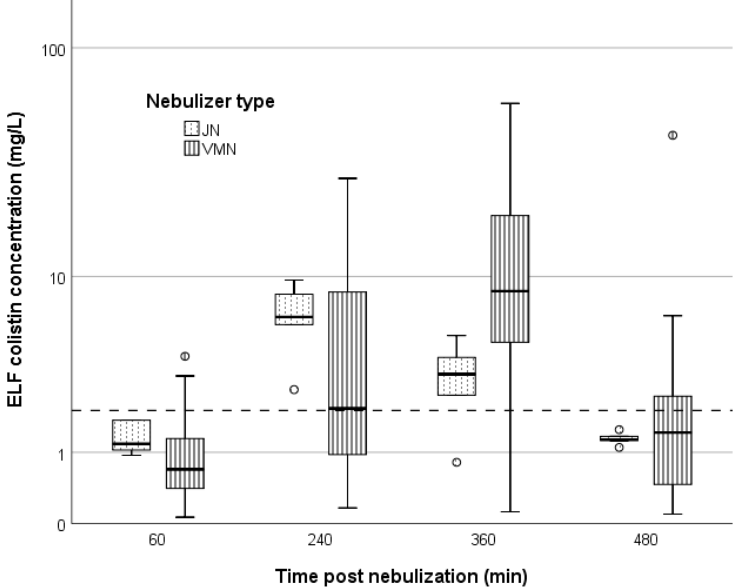
Figure 2. Colistin concentration in the ELF at 60, 240, 360 and 480 min after inhalation of 2 million international units of colistimethate sodium via jet nebulizers (dotted boxplots) or vibrating mesh nebulizers (vertical line boxplots). The dashed line represents the European Committee on Antimicrobial Susceptibility Testing (EUCAST) breakpoint for susceptible Enterobacterales and Acinetobacter spp. (2 mg/L). Circles represent outliers. ELF: epithelial lining fluid, JN: jet nebulizers, VMN: vibrating mesh nebulizers.